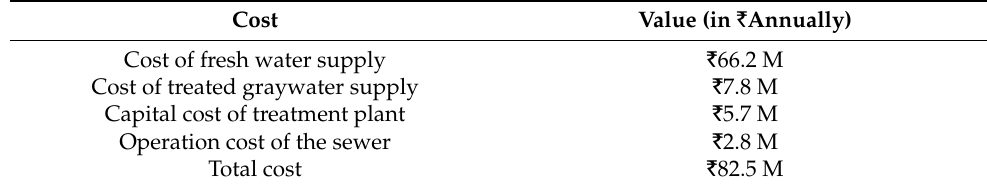
Table 2. Cost split up for implementation of local on-site graywater reuse: network in Figure